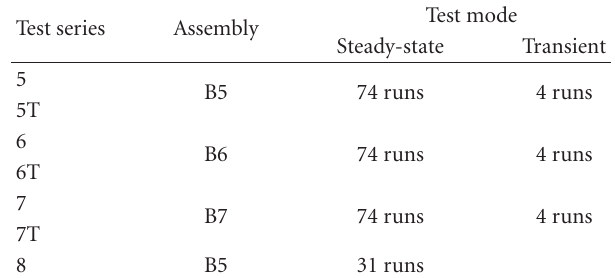
Table 7: Test series for void fraction measurements. Table 8: Average absolute errors in steady-state DNB tests